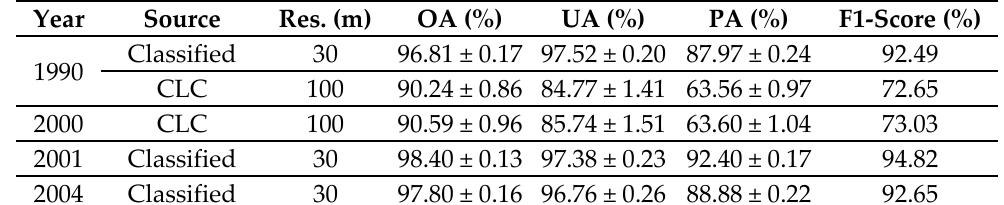
Table 4. OA%, UA%, PA% and F1-score% for time series of binary grassland/non-grassland map- pings produced by supervised classification for the whole N2K boundary plus the 5-km buffer area